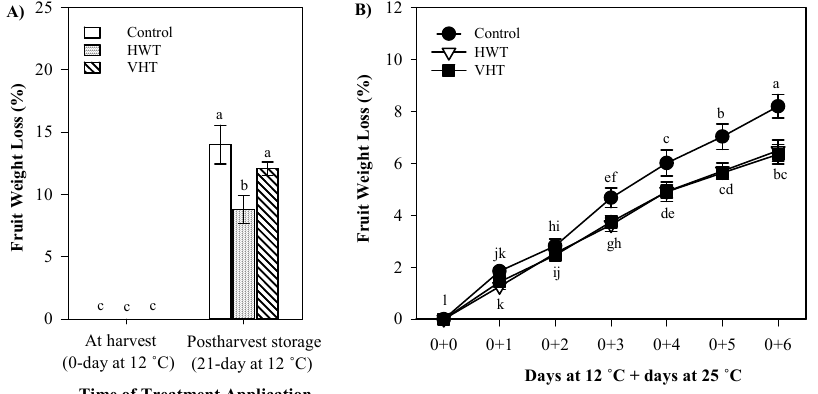
Figure 2. Effect of the heat treatments applied at harvest and post-harvest storage on the weight loss ( A , B ) of mango fruits. Error bars show standard errors of the means ( n = 3). Different letters indicate significant difference according to LSD at p ≤ 0.05.